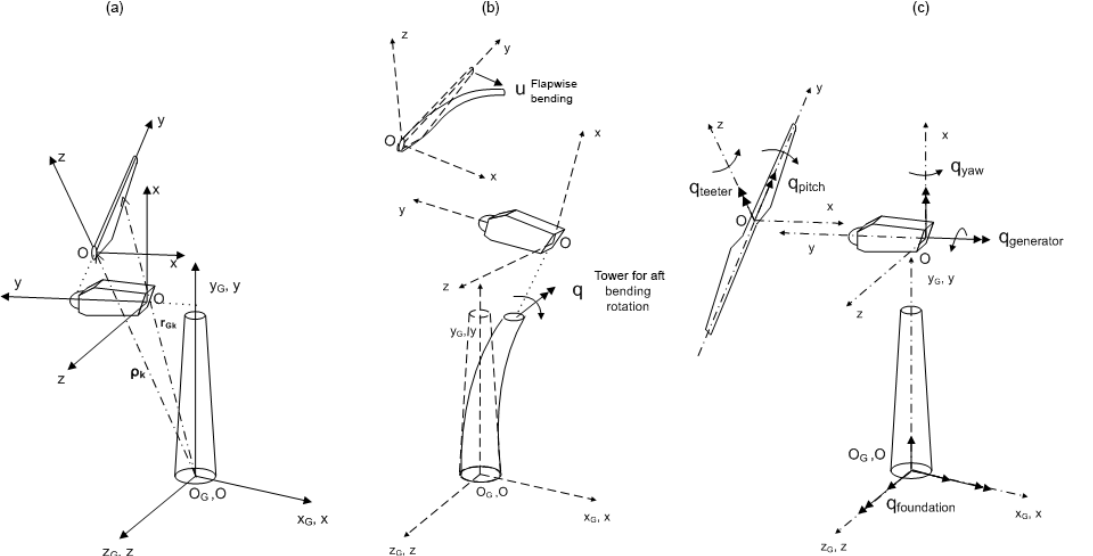
Figure 7. (a) Wind turbine inertial frame and local frame of the various components, (b) realization of multibody kinematics and examples of elastic q DOFs. (c) Realization of multibody kinematics and examples of controlled or free-motion q